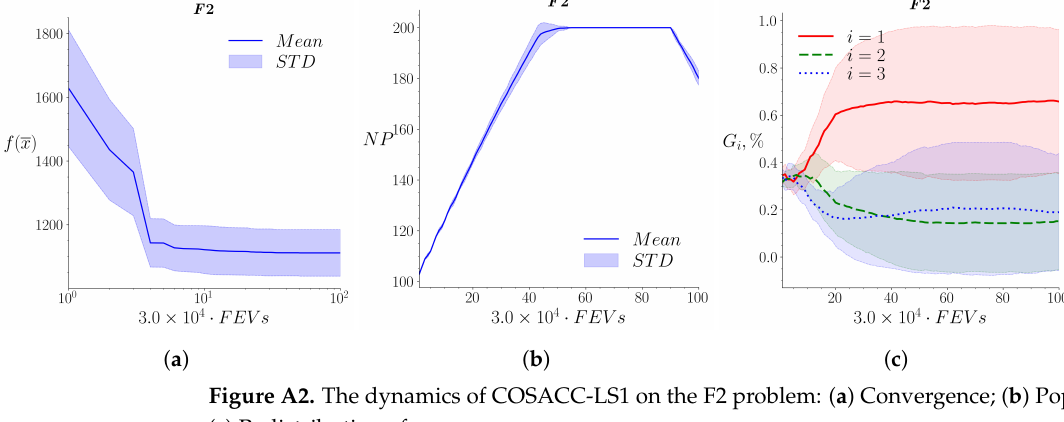
Figure A2. The dynamics of COSACC-LS1 on the F2 problem: ( a ) Convergence; ( b ) Population size;